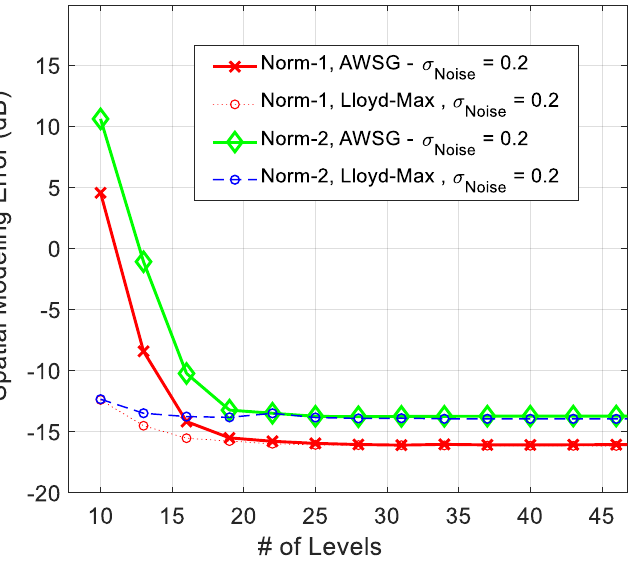
Figure 6. Comparison between the spatial modeling error of norm-1 (MAE) and norm-2 (RMSE) in convergence process of